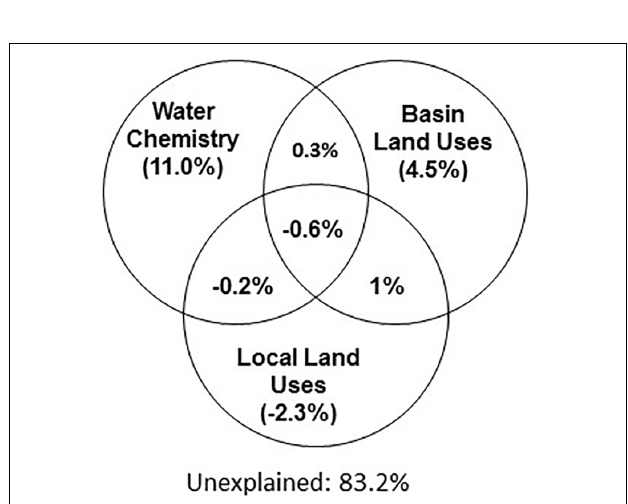
FIGURE 4 | Water chemical properties represent the main explanatory variable for the microbiome composition (ca. 11% among all sites). Variation Partition Analysis performed with 3 data sets (basin and local land use as well as water chemistry) to explain the variation in the microbiome composition. The combination of land uses and water chemistry explain 16.8% of microbiome variability. See Supplementary Information for an explanation of the estimation of explained